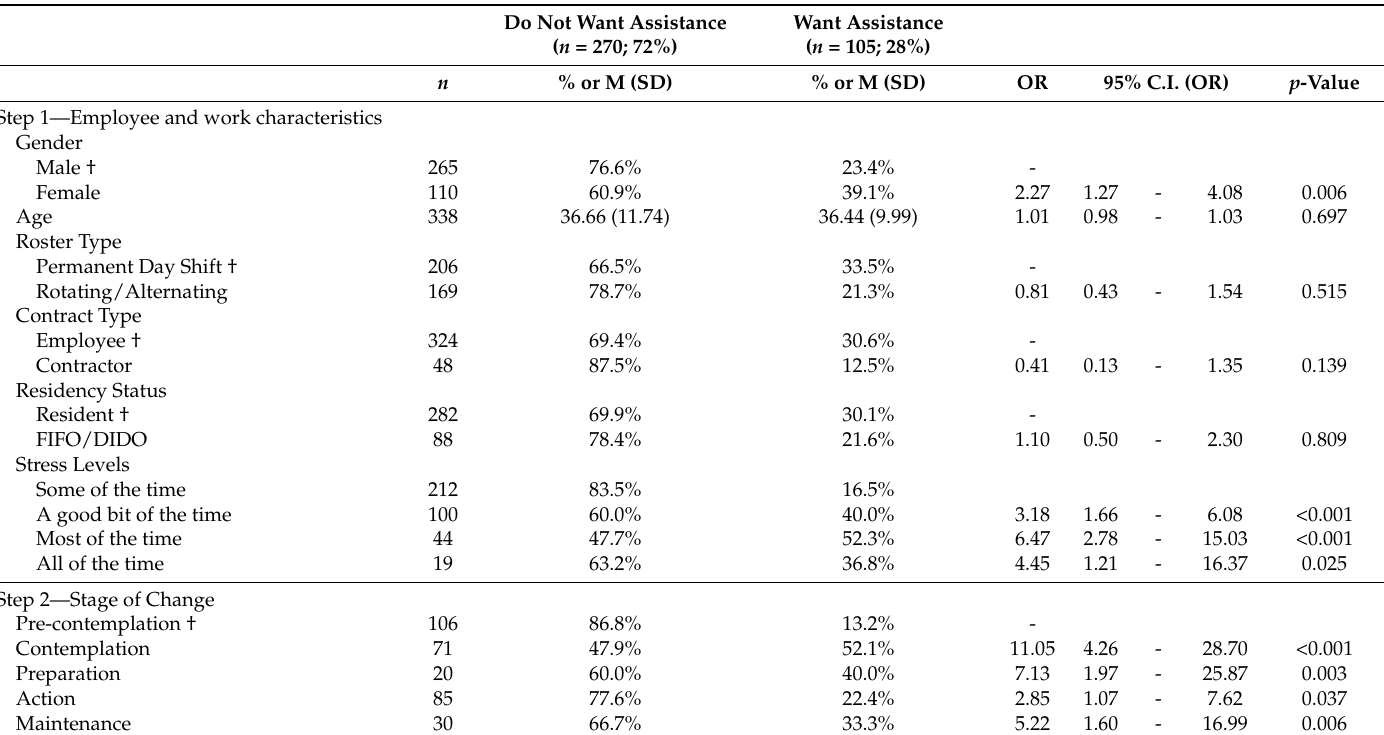
Table 5. Logistic regression predicting the likelihood of desiring assistance with stress